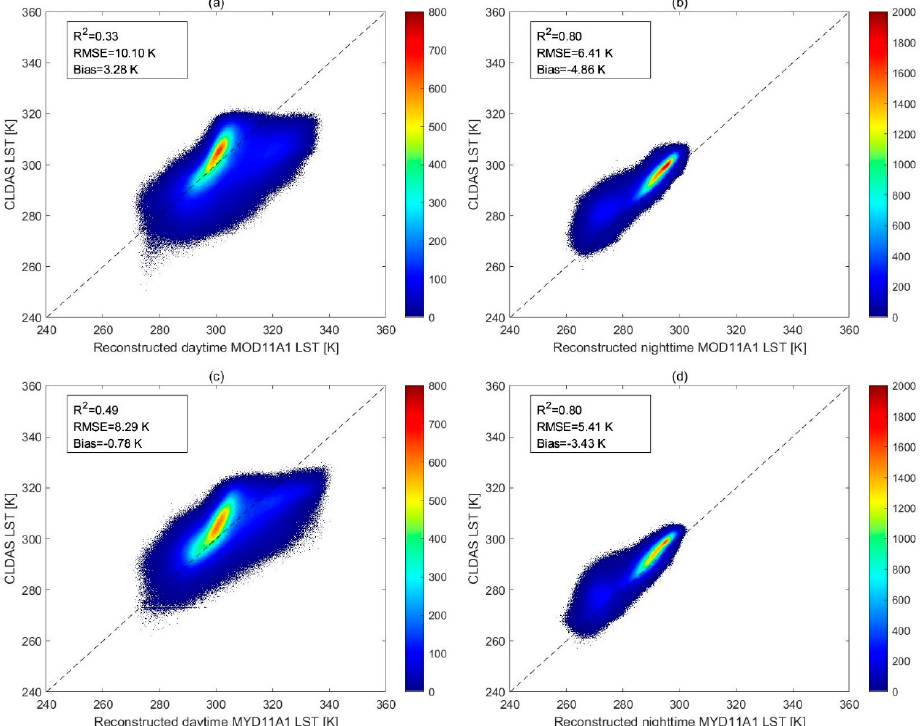
Figure 14. Density scatter plots between the reconstructed LSTs of ( a ) MODLSTD_Rec_SG; ( b ) MODLSTN_Rec_SG; ( c ) MYDLSTD_Rec_SG, and ( d ) MYDLSTN_Rec_SG, and the corresponding CLDAS LSTs from June to August 2018. Color bar represents the counts of the points falling in each square.